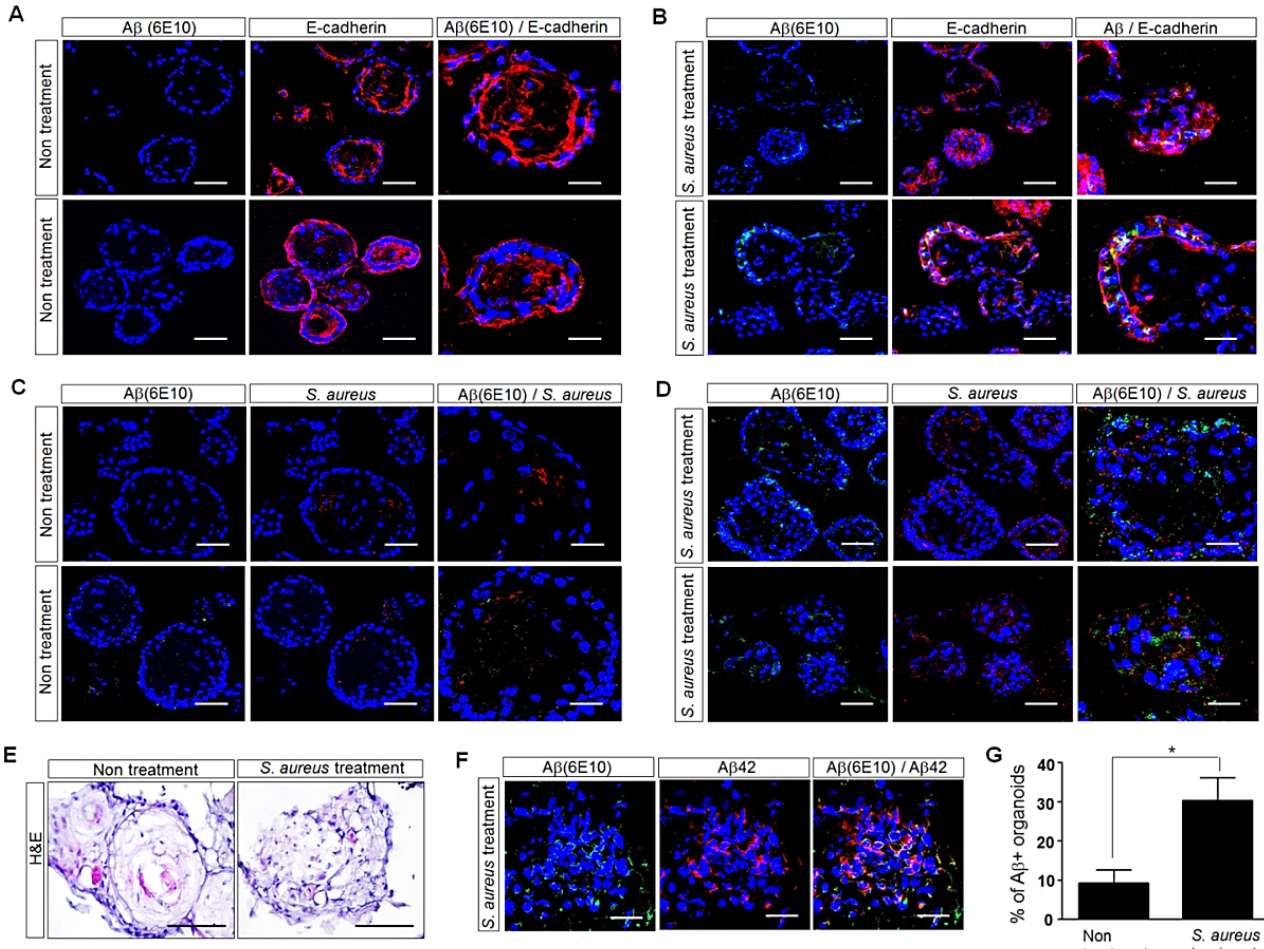
Figure 4. Histological analyses of human-palatine-tonsil-specimen-derived tonsil organoids subjected to immunohistostaining. ( A , B ) Confocal-microscopy images of human tonsil organoids cultured in the absence or presence of S. aureus at an MOI of 10 after the double staining of the OCT-embedded sections with the A β -specific 6E10antibody (green) and the antibody against tonsil-epithelium marker E-cadherin (red). Nuclei were labeled with DAPI (blue). Scale bars: 50 µ m, 20 µ m. All images are representative of two or three independent experiments. ( C , D ) Confocal-microscopy images of human tonsil organoids cultured in the absence or presence of S. aureus at an MOI of 10 after the double staining of the OCT-embedded sections with antibodies against A β -specific 6E10 (green) and S. aureus bacteria (red). Nuclei were labeled with DAPI (blue). Scale bars: 50 µ m, 20 µ m. All images are representative of two or three independent experiments. ( E ) H&E staining of the OCT-embedded sections 5 days after incubation of human tonsil organoids in culture medium. Scale bar: 100 µ m. ( F ) Confocal-microscopy images after the double staining of OCT-embedded organoid sections with antibodies against 6E10antibody (green) or A β 42 antibody (red) to detect A β deposition. Scale bar: 20 µ m. ( G ) A β -positive organoids were counted. Each bar represents the mean percent of the A β -positive organoids. Values are the means (SD). A Student’s t-test was used to determine the statistical differences between two different samples. * p < 0.05.